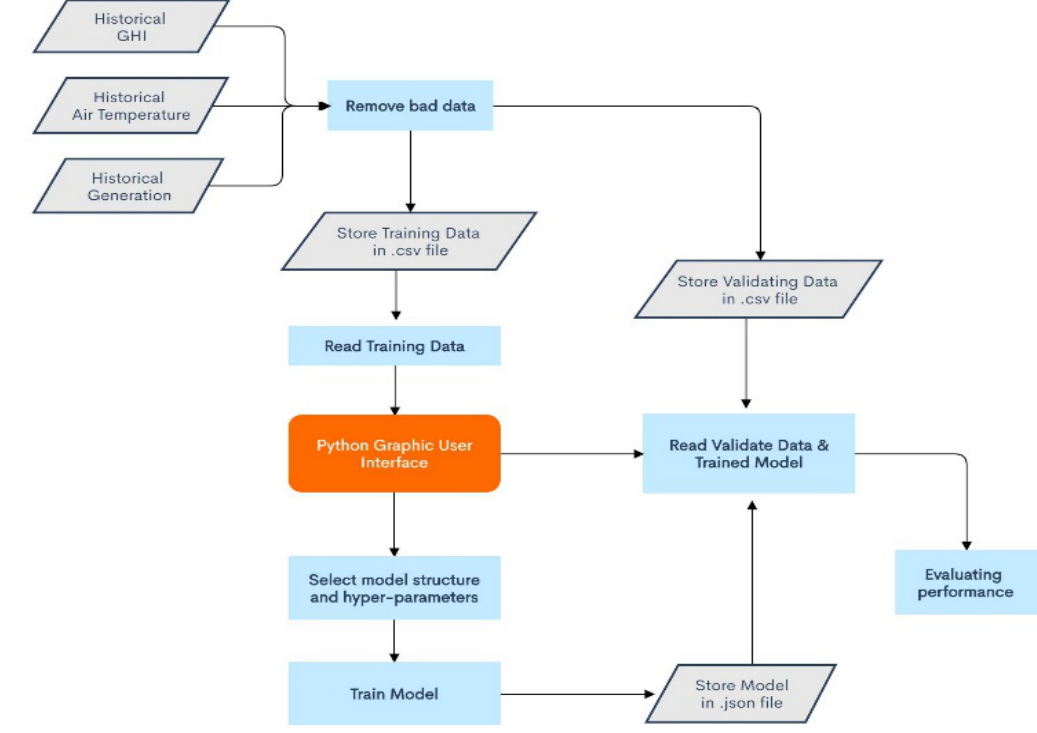
Figure 6. The block diagram of the proposed procedure